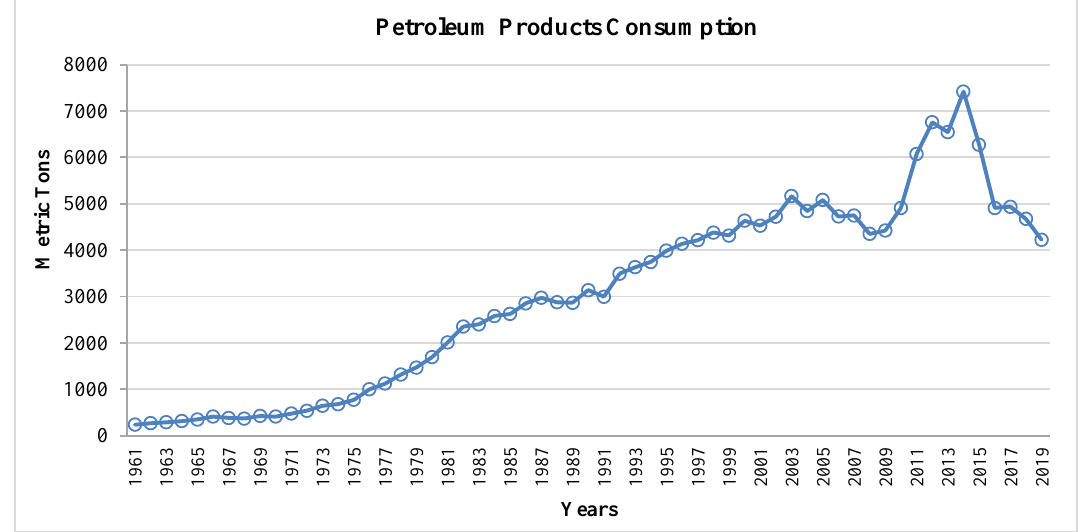
Figure 2. The evolution of petroleum products consumption (1961-2019).